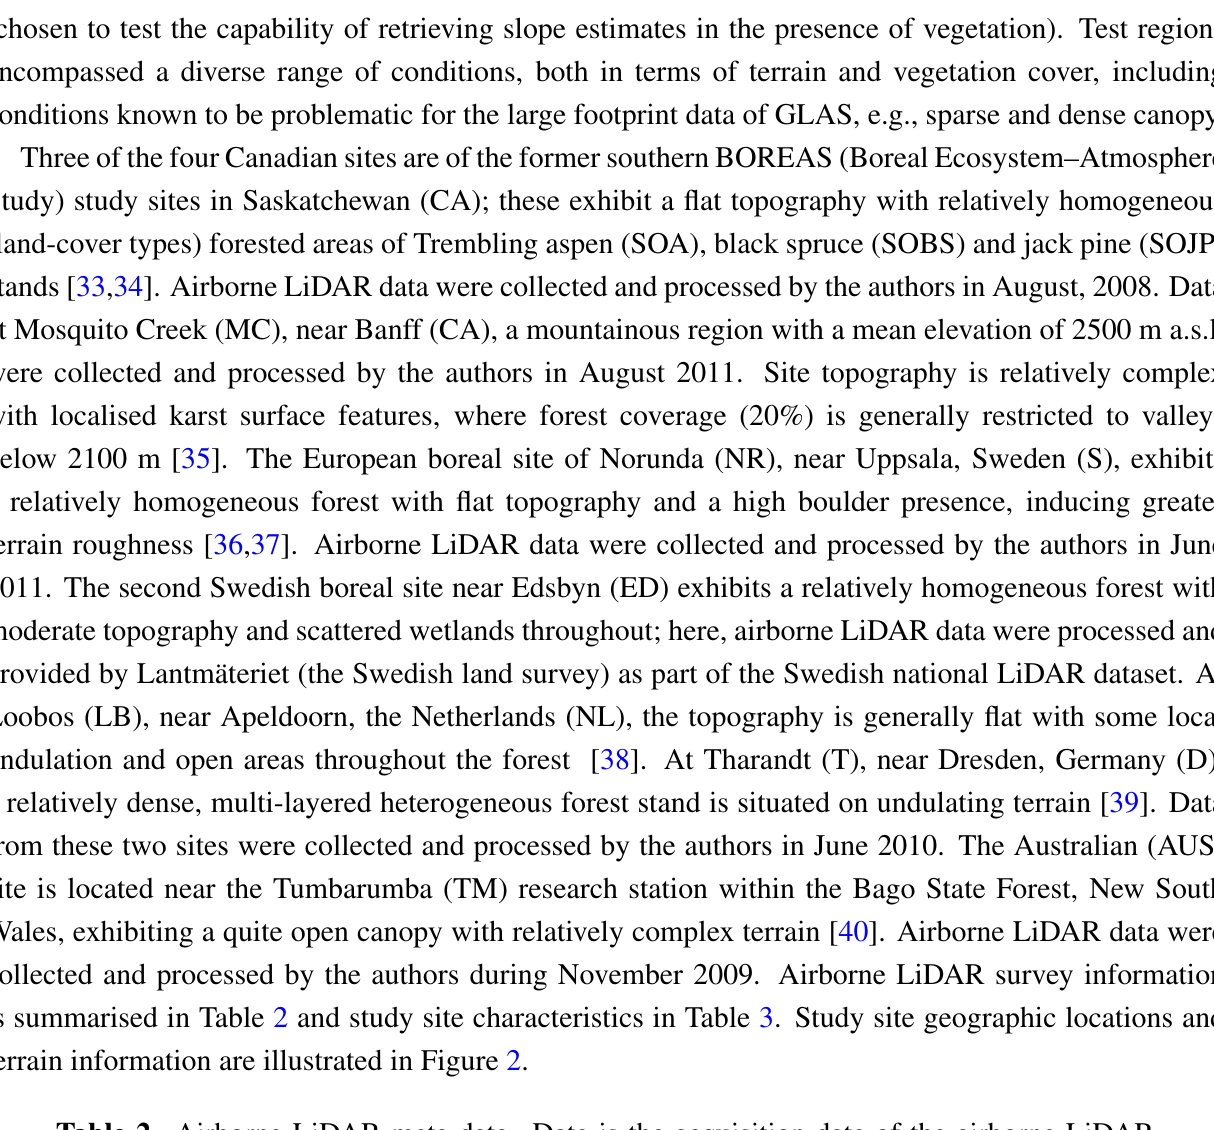
Table 2. Airborne LiDAR meta data. Date is the acquisition date of the airborne LiDAR data, and P is the mean point density of the airborne LiDAR data per square meter ( pm − 2 ). D See the text for the site code